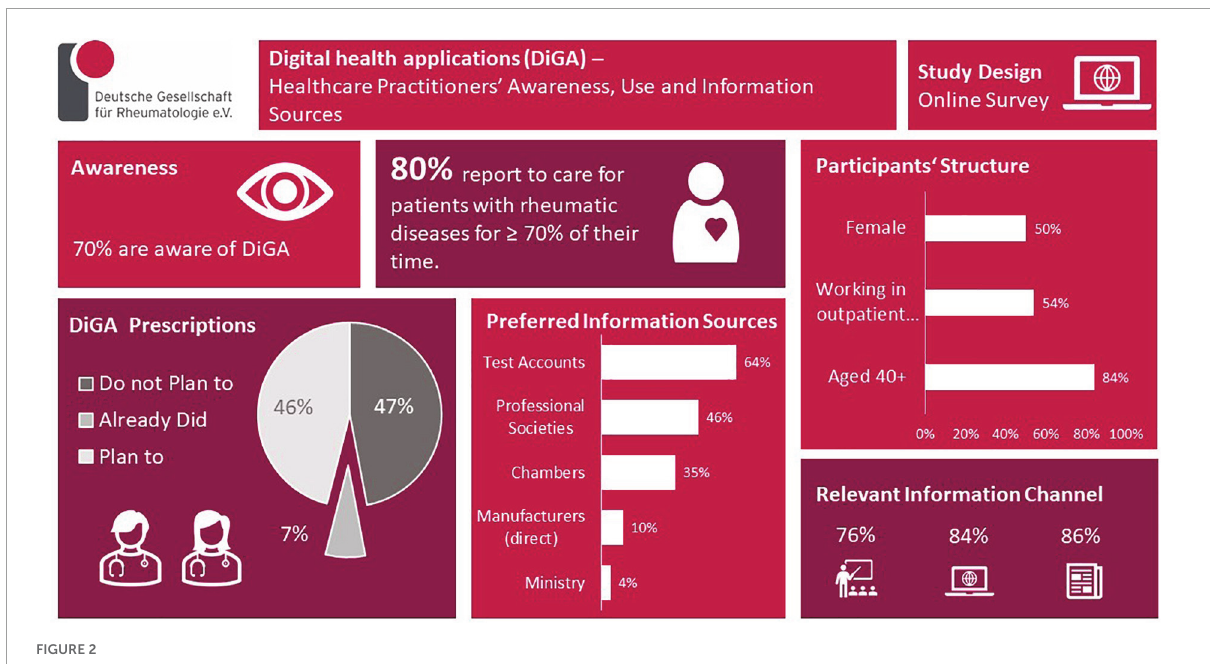
FIGURE2 Infographic summarizing the study